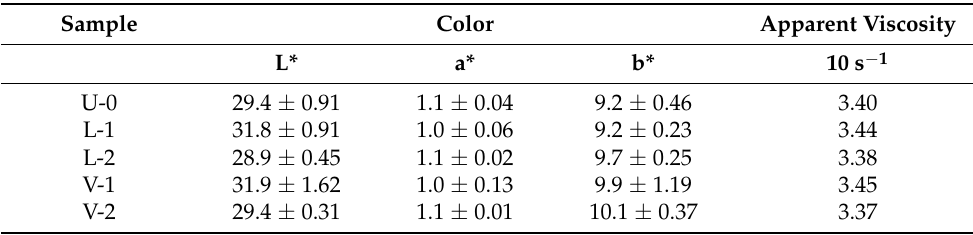
Table 5. Physical properties of yogurt samples. Apparent viscosity has been calculated from three The apparent viscosity (10 s −1 ) was identical among samples ranging from 3.37 to 3.45 separate measurements at a shear rate 1 (s − 1 ) from the upward flow curve (Pas) with the Ostwald–de (Table 5). Moreover, the color was measured to be similar between the samples. All the Waele equation. Color measurement means and standard deviations are based on three measurements samples showed shear thinning behavior (n < 1) as the apparent viscosity decreased by per increasing the shear rate in all the samples.